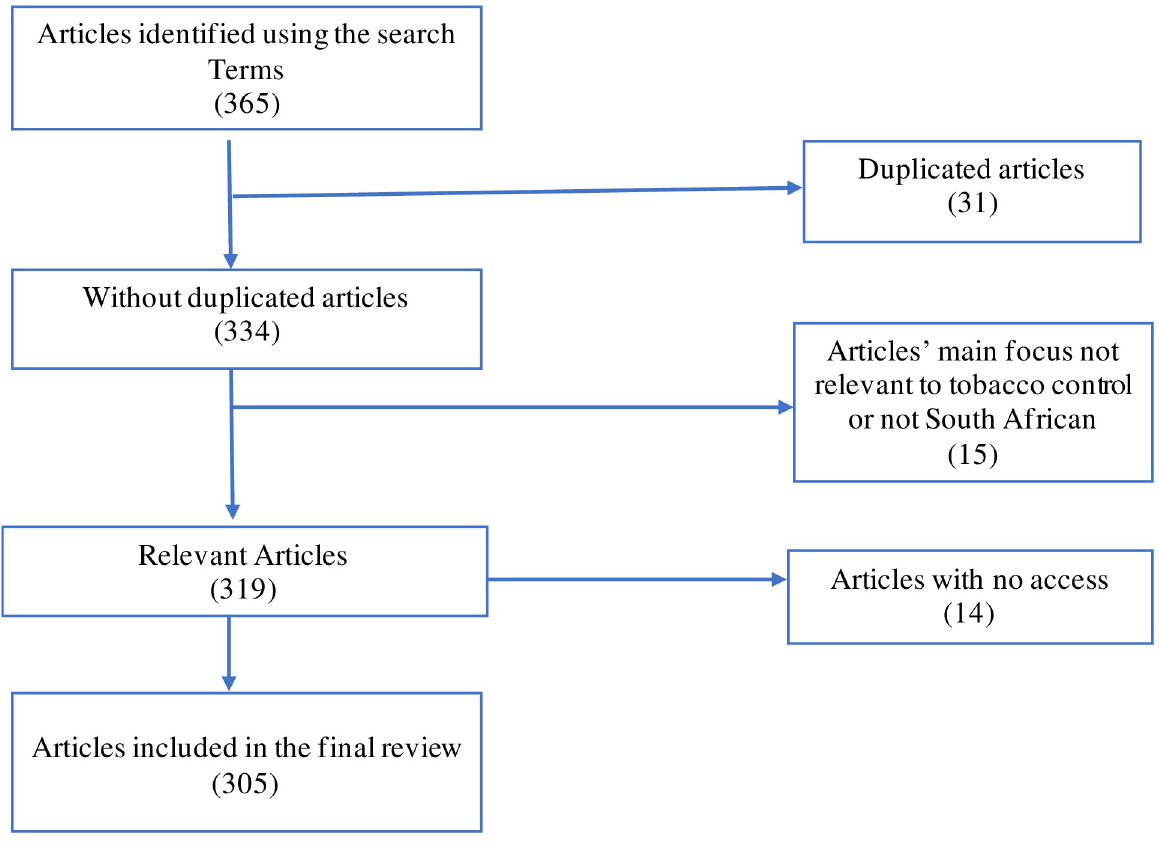
Fig 2. Flowchart of news articles selected for